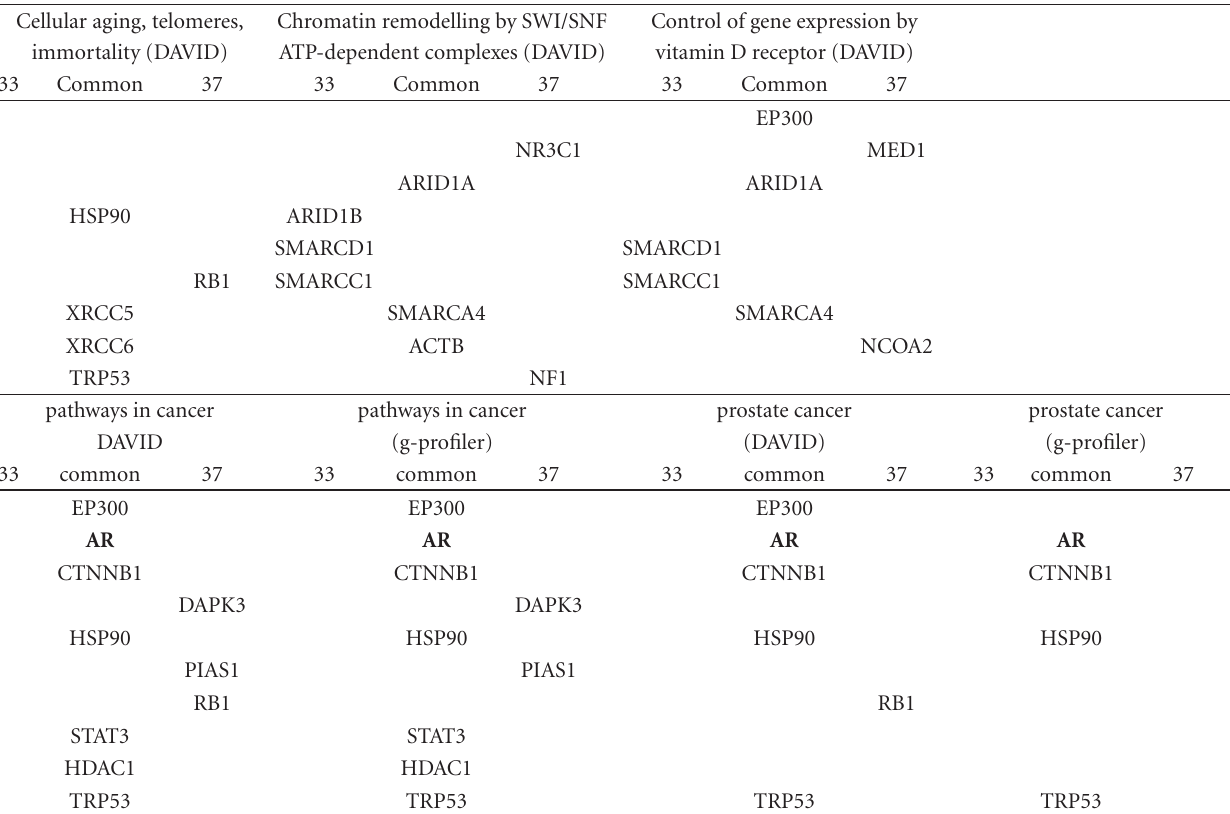
Table 3: Top half: gene lists representing the BIOCARTA pathways “telomeres, telomerase, cellular aging, and immortality”, “chromatin remodeling by hSWI/SNF ATP-dependent complexes” and “control of gene expression by vitamin D receptor” found to be overrepresented among the known AR-interacting proteins identified in the N-TAP purifications by the bioinformatics tool DAVID. Bottom half: gene lists representing the “Kegg pathway” “pathways in cancer”, and “prostate cancer” identified as being overrepresented among the known AR- interacting proteins identified in the N-TAP purifications by the bioinformatics tool “DAVID” and “g-profiler”. Listed are the interacting proteins that were unique for the proliferating cells (33), interacting proteins that were unique for the nonproliferating cells (37), and interacting proteins common to both (common). The AR is